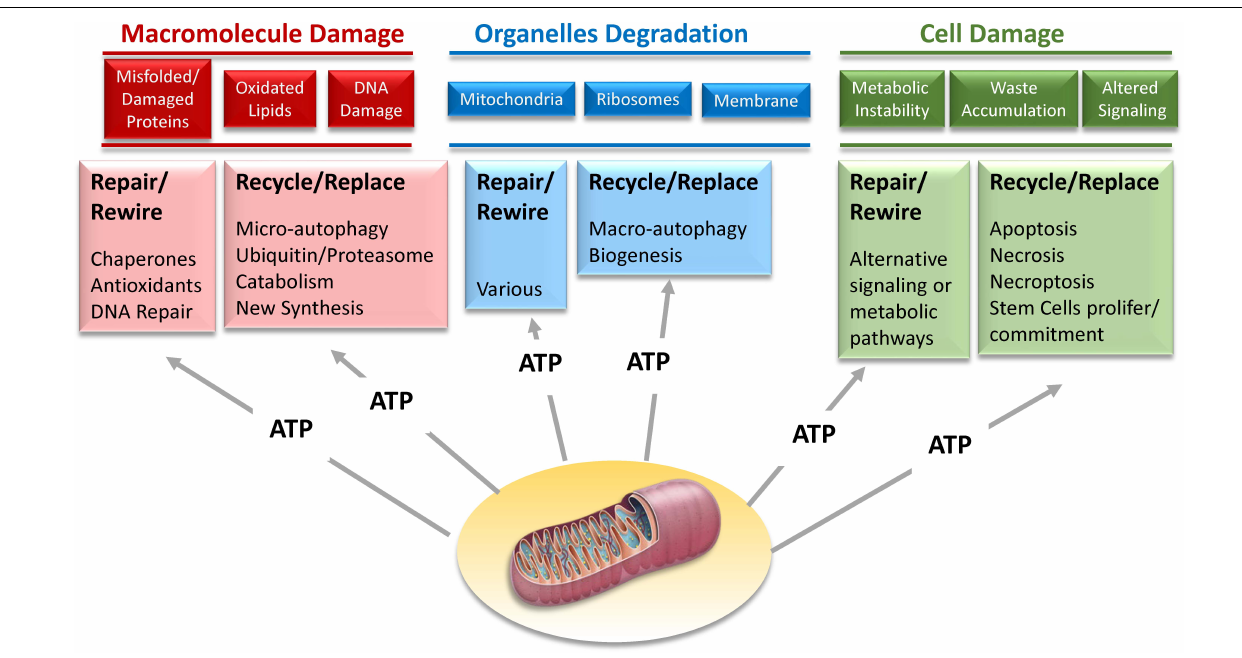
Frontiers in Physiology |